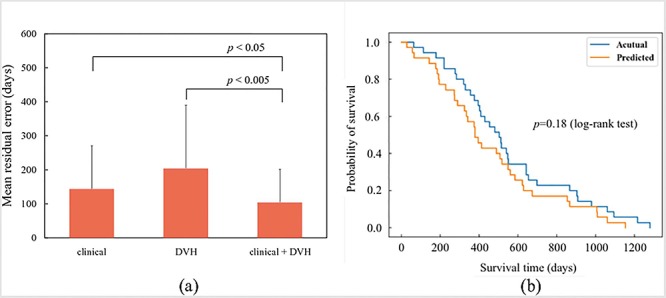
(a) Mean residual error from LOOCV by using each feature group, i.e. clinical features, DVH features and combination of clinical and DVH features. The prediction accuracy when using the combination of clinical and DVH features was significantly improved (P < 0.05 and 0.005, respectively, paired t-test). (b) Survival curve using actual and predicted survival time. There is no significant difference (P = 0.18, log-rank test).